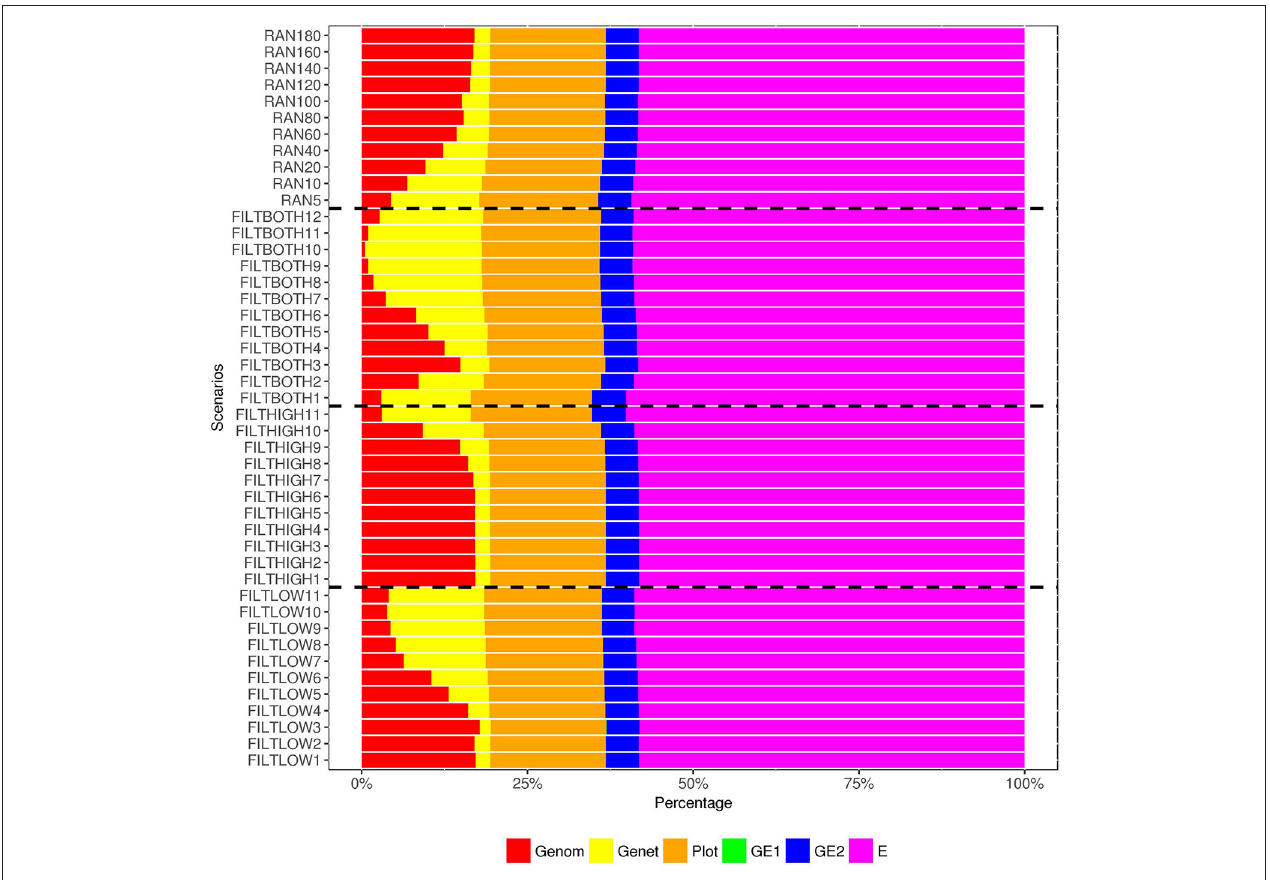
FIGURE 6 | Percentage of variance components 1, 2 over the total phenotypic variance for dry matter yield. 1 Genom, Additive genomic variance; Gene, Residual genetic variance; PLOT, random plot variance; GE1, family × sowing year × location × management variance; GE2, family × sowing year × location × management × farming year variance; E, residual environment variance. 2 GE1 is too small to be visible, so that there are only five variances can be observed in this